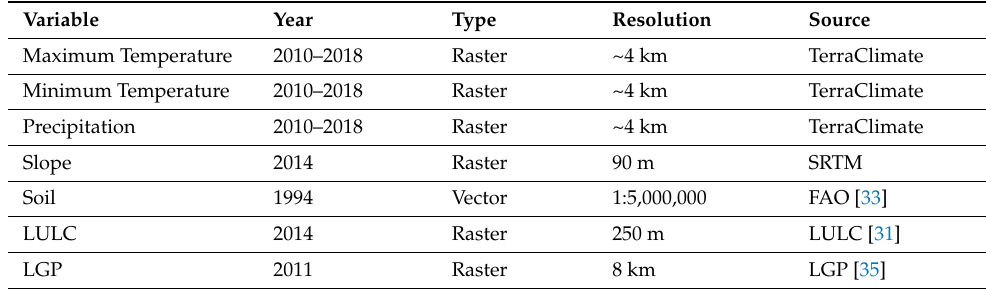
Table A1. Parameters related information and their